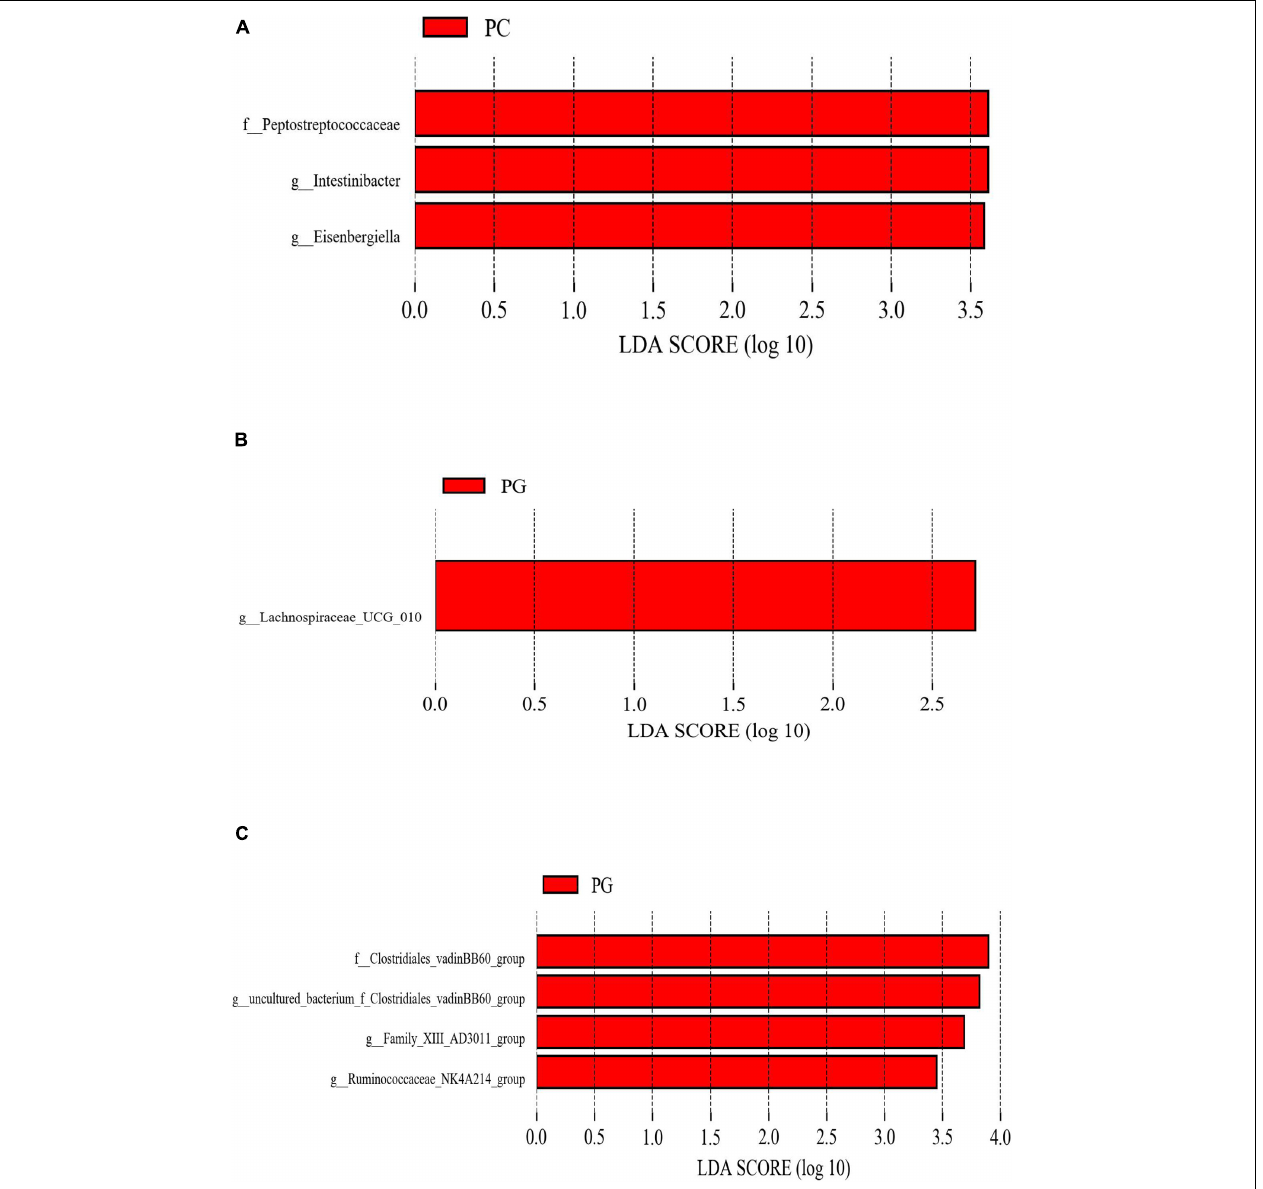
FIGURE 2 | The different phylotypes differed between groups using LEfSe analysis. These figures show the bacteria of which the LDA Score is greater than the set value (the default setting is 2.0) between groups PC and PA. (A) Groups PC and PG. (B) Groups PG and PA. (C) The length of the histogram represents the size of the difference species (i.e., LDA Score), and the different colors represent the different groups. PC, basal diet + SNE; PA, basal diet extra antibiotics + SNE; PG, basal diet extra B. licheniformis +